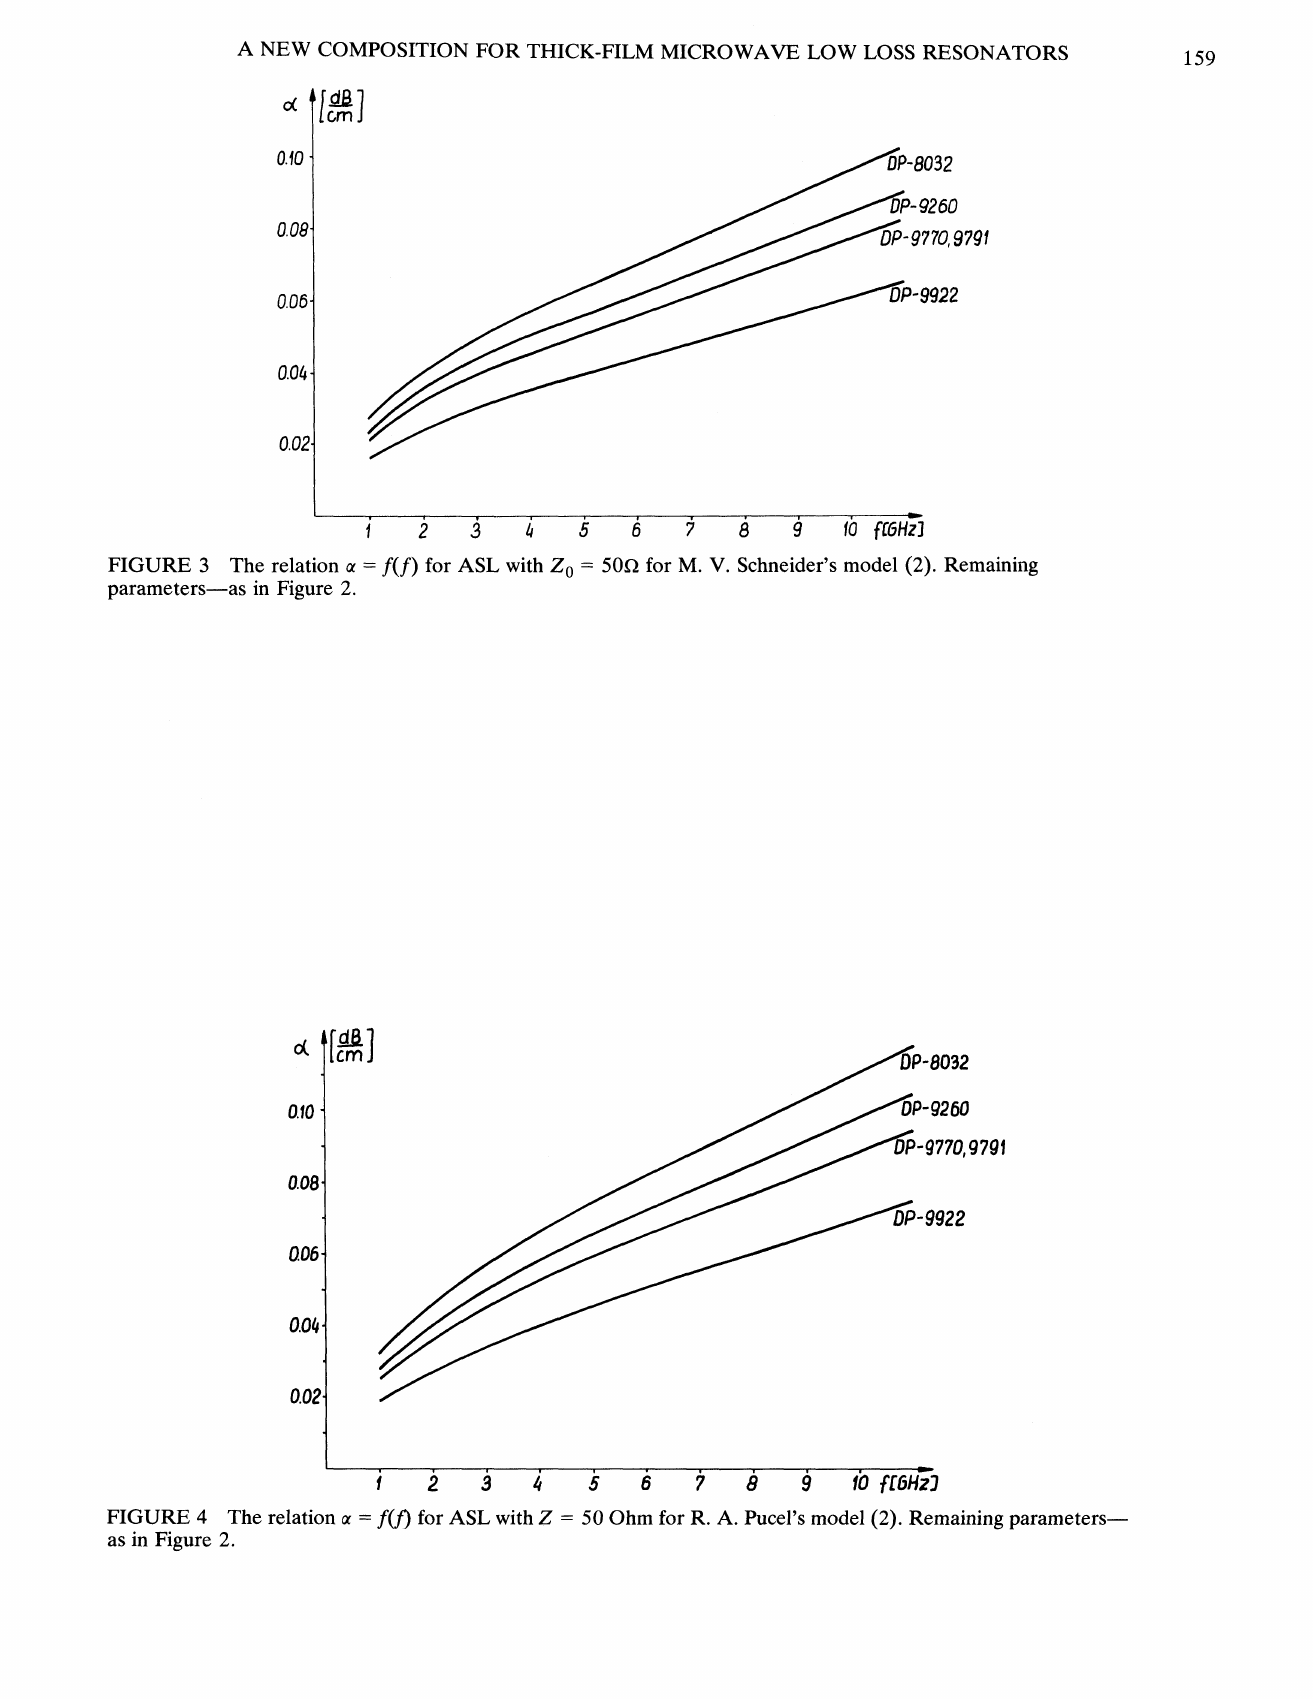
50 for M. V. Schneider’s model (2). Remaining 0